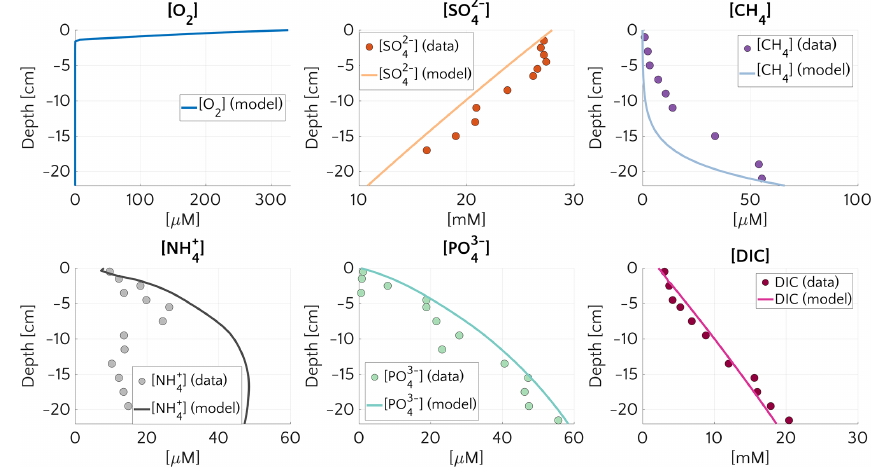
Figure 1. Pore water concentration profiles for O 2 , SO 2 − 56m water depth). Dots represents the measurements and continuous lines the simulated results. The boundary conditions and model pa- rameters employed in the model are reported in Table S4, the measured organic carbon content in Table S5. For O 2 no measured profile is